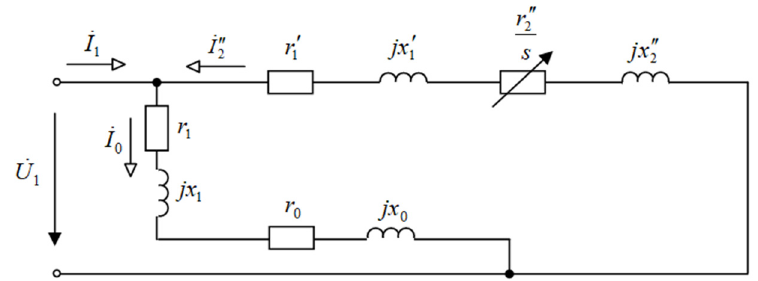
Figure 3. L-shaped equivalent circuit of a three-phase induction motor.